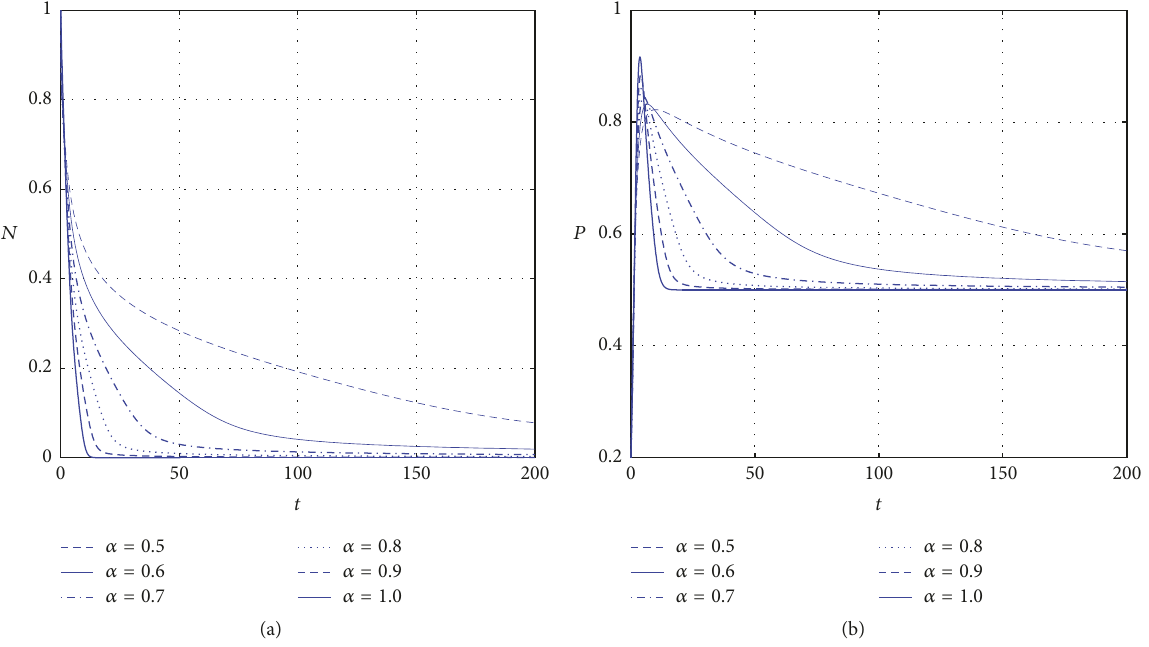
Figure 2: Solutions of system (6) with initial value (1, 0.2) and parameter values: 𝑠 = 1 , 𝑘 = 0.5 , 𝑚 = 0.2 , ℎ = 0.1 , 𝜔 = 0.7 , 𝑎 = 1 , 𝑏 = 0.5 , 𝑐 = 0.05 , and Δ𝑡 = 0.1 , for various values of 𝛼 . All numerical solutions are convergent to axial equilibrium (0, 0.5). Solution of system (6) with larger order of fractional derivative (𝛼) has faster convergence compared to that with smaller 𝛼 .